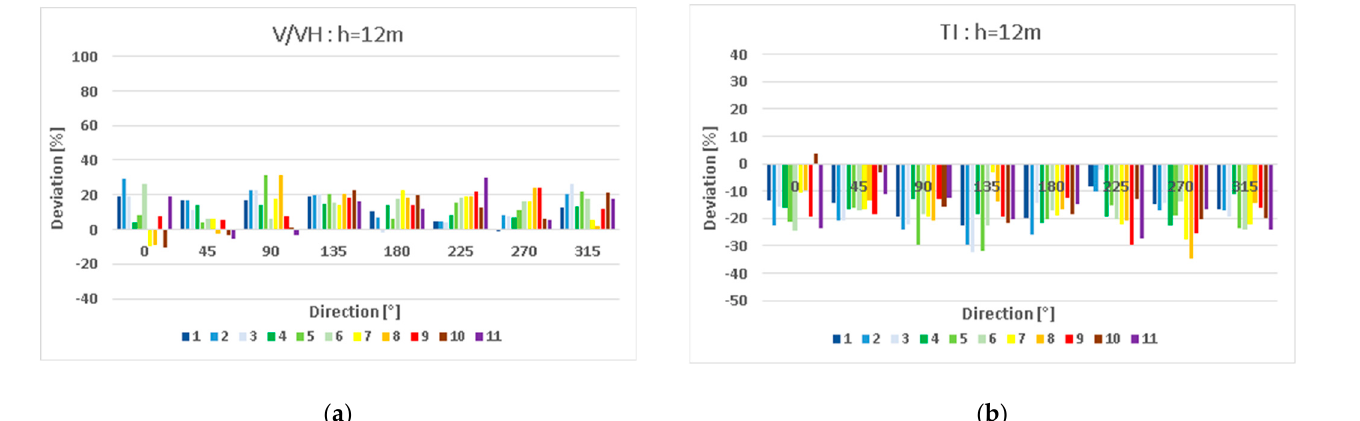
Figure 26. Mean absolute deviations of the wind ( a ) and turbulence intensity ( b ) per direction for the 11 probe validation points at height h = 12 m with OpenFOAM.